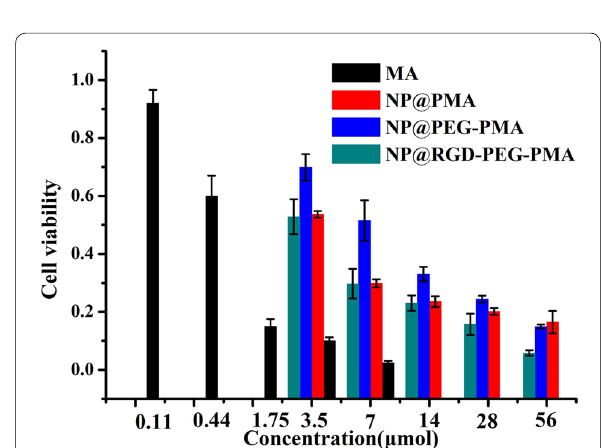
Fig. 5 In vitro cytotoxicity assays. In vitro cytotoxicity of MA, NP@ PMA, NP@PEG–PMA, and NP@RGD–PEG–PMA nanoparticle against tumor cells after a 72‑h co‑incubation ( n line: